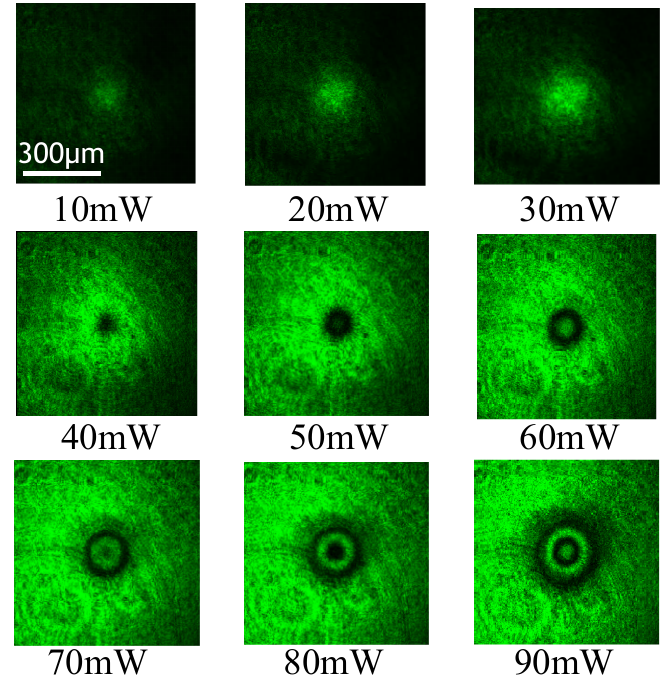
Figure 4. Equilibria ring patterns were experimentally observed for different powers of the blue light beam. After a long period of evolution, snapshots were observed for different powers, as denoted in the lower part of each